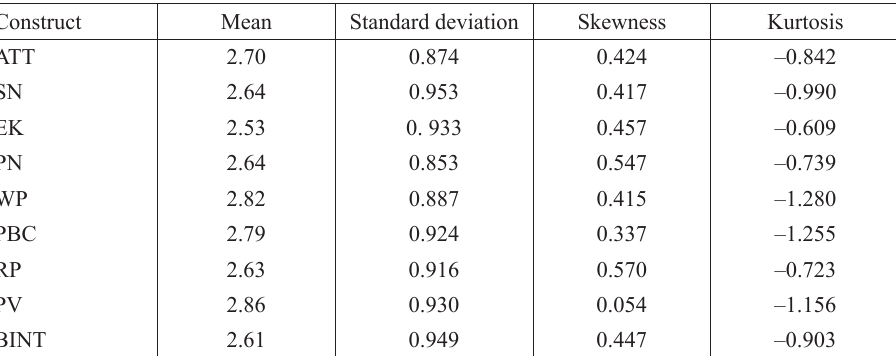
Table 2. Constructs’ descriptive